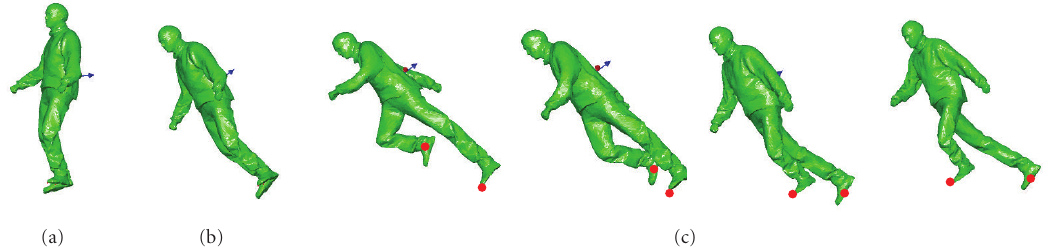
Figure 8: Posing of the performer model (dense: 20k triangles, coarse: 1k triangles). We place a frame on the back and handles on the feet (a). We first adjust the global orientation of the performer (b). We can pose the performer in a running sequence by translating the handles (c).